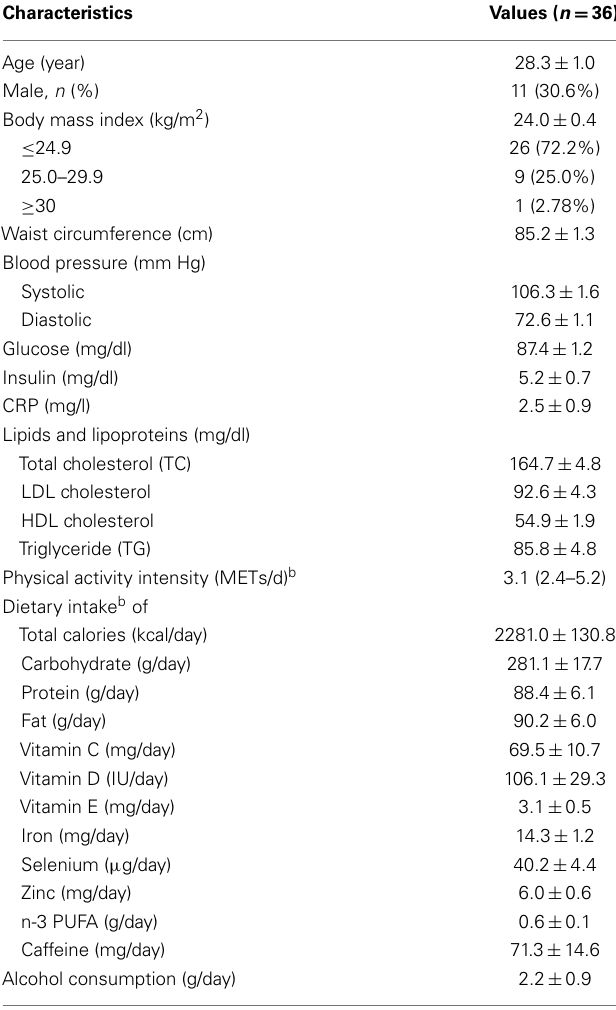
Table 1 | Demographic characteristics of participants a